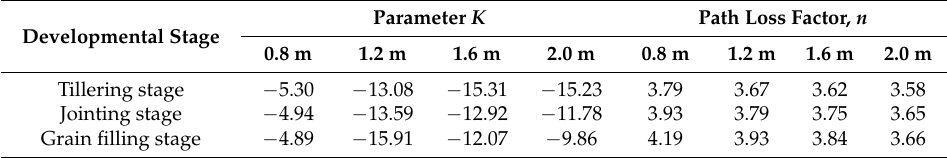
Table 1. One-slope log-distance model regression